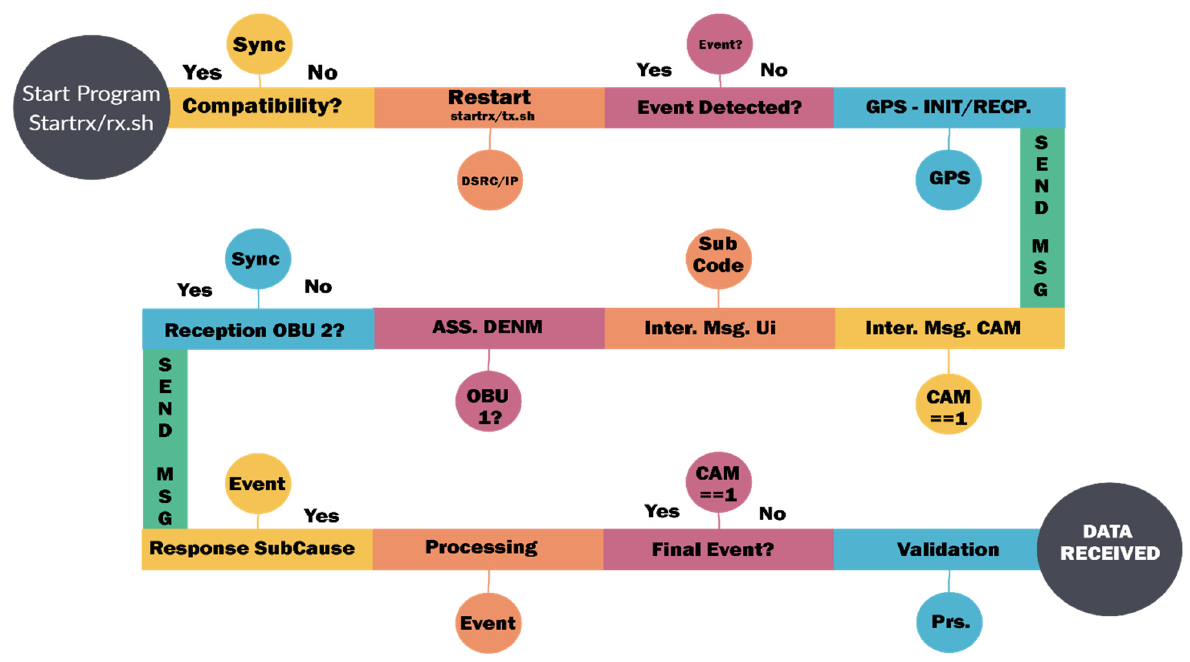
Figure 18. Data flow diagram between OBU1-OBU2.